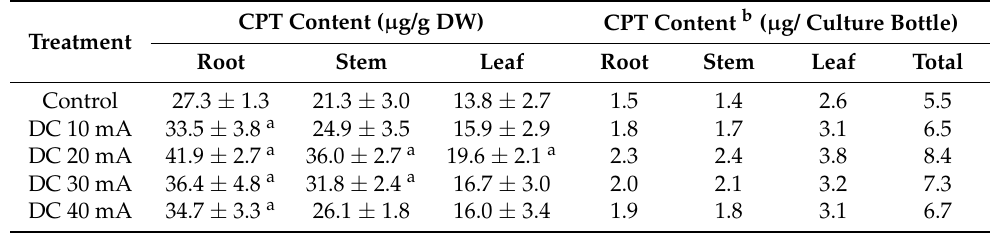
Table 4. Average CPT concentrations in different parts of 5-month-old tissue culture plants of O. ridleyana treated with DC current at 10–40 mA and the estimated CPT content per 30 mL culture bottle.